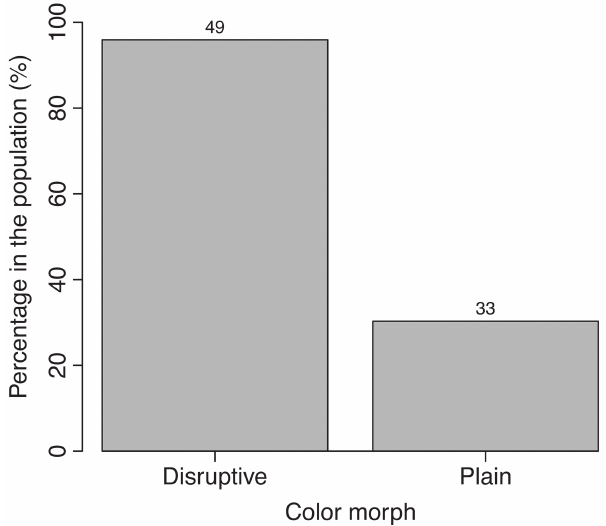
Fig. 5. Percentage of occurrence of individuals of Hippocampus reidi with body-color different from the background color, for each color morph. Tags above each column indicate the absolute number of